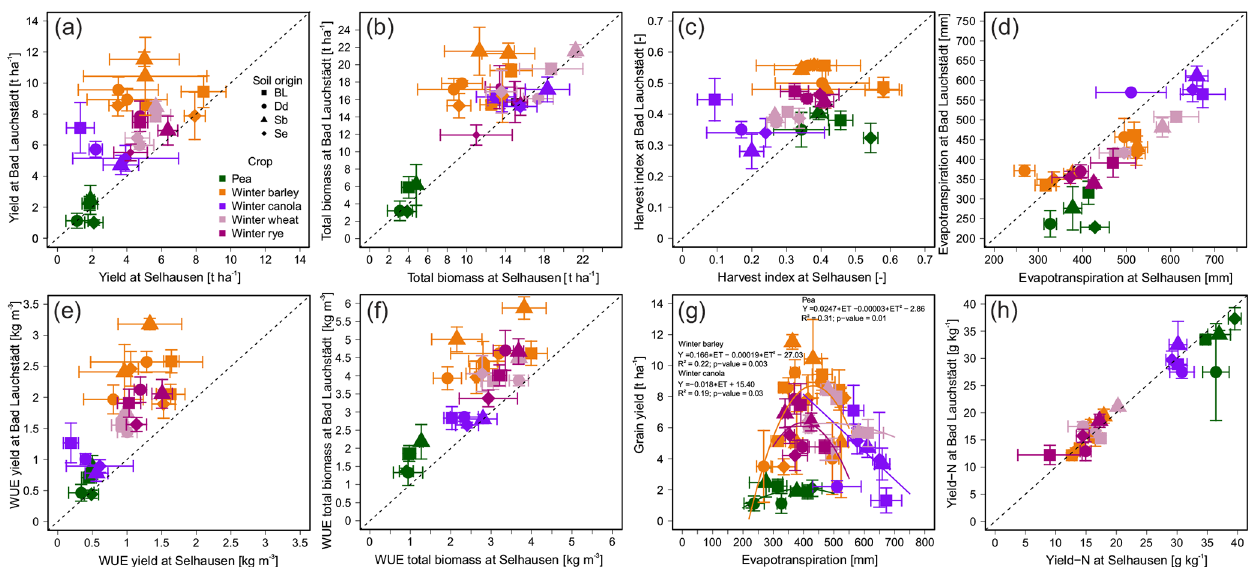
Figure 5. Comparison of parameters related to annual crop yield and ET for the same soils from Bad Lauchstädt, Dedelow, Sauerbach and Selhausen (three lysimeters each origin) at the two sites with a relatively dry (Bad Lauchstädt) and wet climate (Selhausen); average values (symbols) and standard deviations (error bars) between observations are from the same soils for (a) observed yield, (b) total biomass, (c) harvest index, (d) evapotranspiration, (e) water use efficiency (WUE) from yield, (f) the WUE from total biomass and (h) nitrogen (N) content in the grain yield as well as (g) the relationship between grain yield and evapotranspiration of all soils and crops during the years